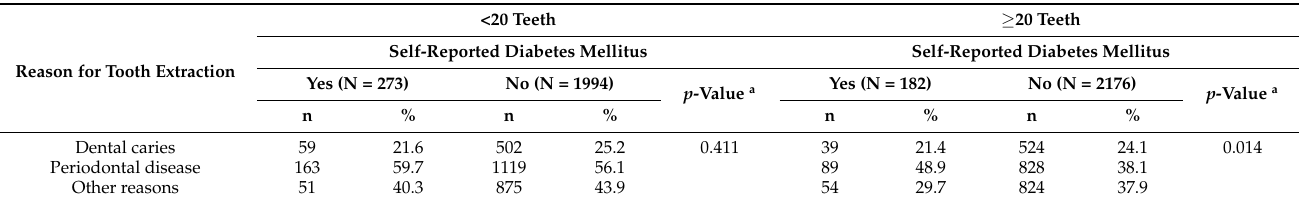
Table 2 shows the reasons for tooth extraction by the number of teeth before extraction. Regardless of the number of teeth, periodontal disease was the main reason for tooth extraction. Among patients with at least 20 teeth present, the prevalence of periodontal disease was higher among patients with self-reported diabetes mellitus than among those without diabetes mellitus (48.9% vs. 38.1%). The prevalence of dental caries was relatively similar in the two groups (21.4% vs. 24.1%). Table 2. Reasons for tooth extraction and number of teeth before extraction.